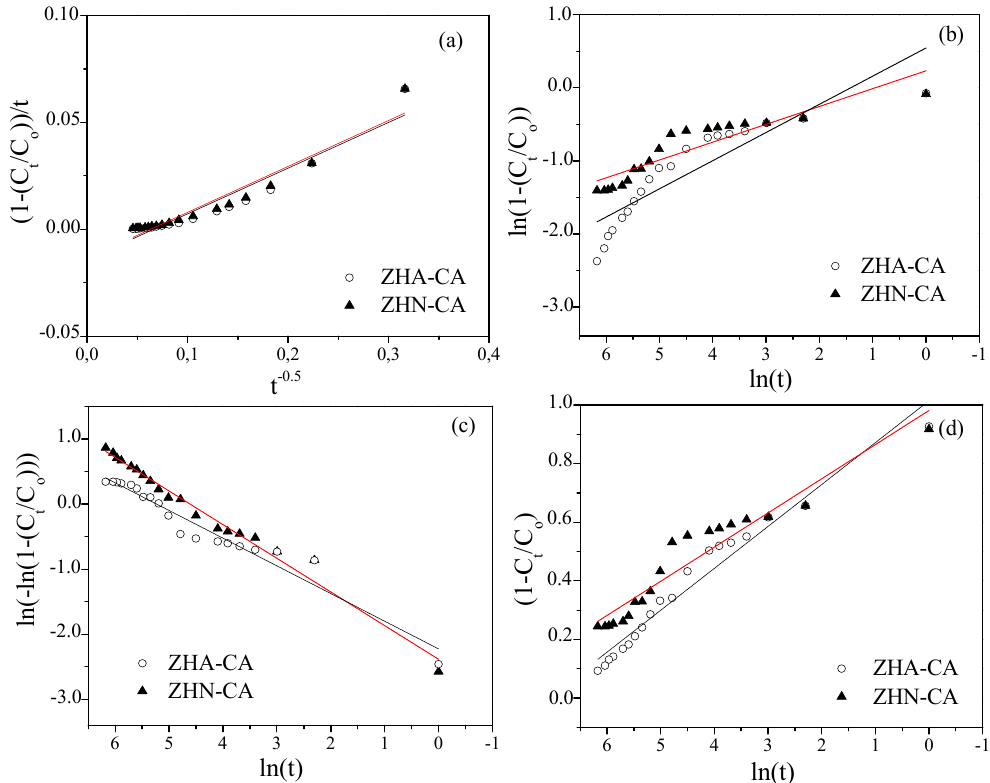
Figure 9. Plots of kinetic models to the experimental release of CA anions from ZHN–CA and ZHA–CA hybrid materials: ( a ) parabolic, ( b ) Freundlich, ( c ) Avrami-Erofe’ev, and ( d ) Elovich models. Table 2. Equations of kinetic models for release analysis and R 2 coefficients of fitted results.